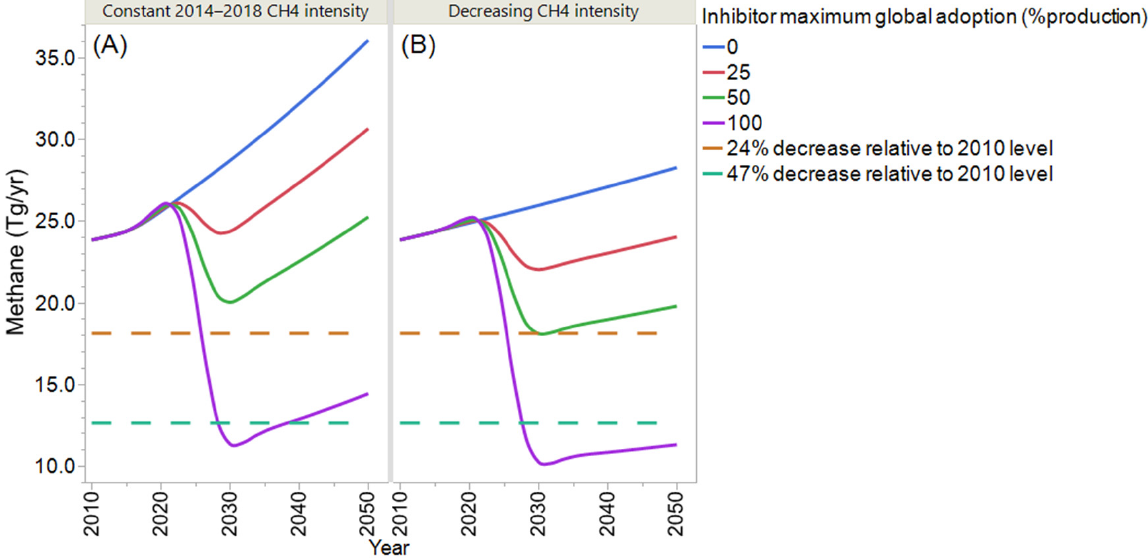
Figure 7. Predicted evolution of enteric methane (CH 4 ) emissions from global bovine milk production between 2010 and 2050 considering ( A ) constant CH 4 intensity and ( B ) declining CH 4 intensity according to Table 1. Adoption of feed additive inhibitors of methanogenesis decreasing CH 4 intensity by 60% is simulated to occur at 0, 25, 50, or 100% of global lamb production. Decreases in enteric CH 4 emissions of 24 and 47% relative to 2010 required to maintain a global temperature increase within 1.5 °C according to different socioeconomic scenarios and climate models [15] are shown in dashed lines.